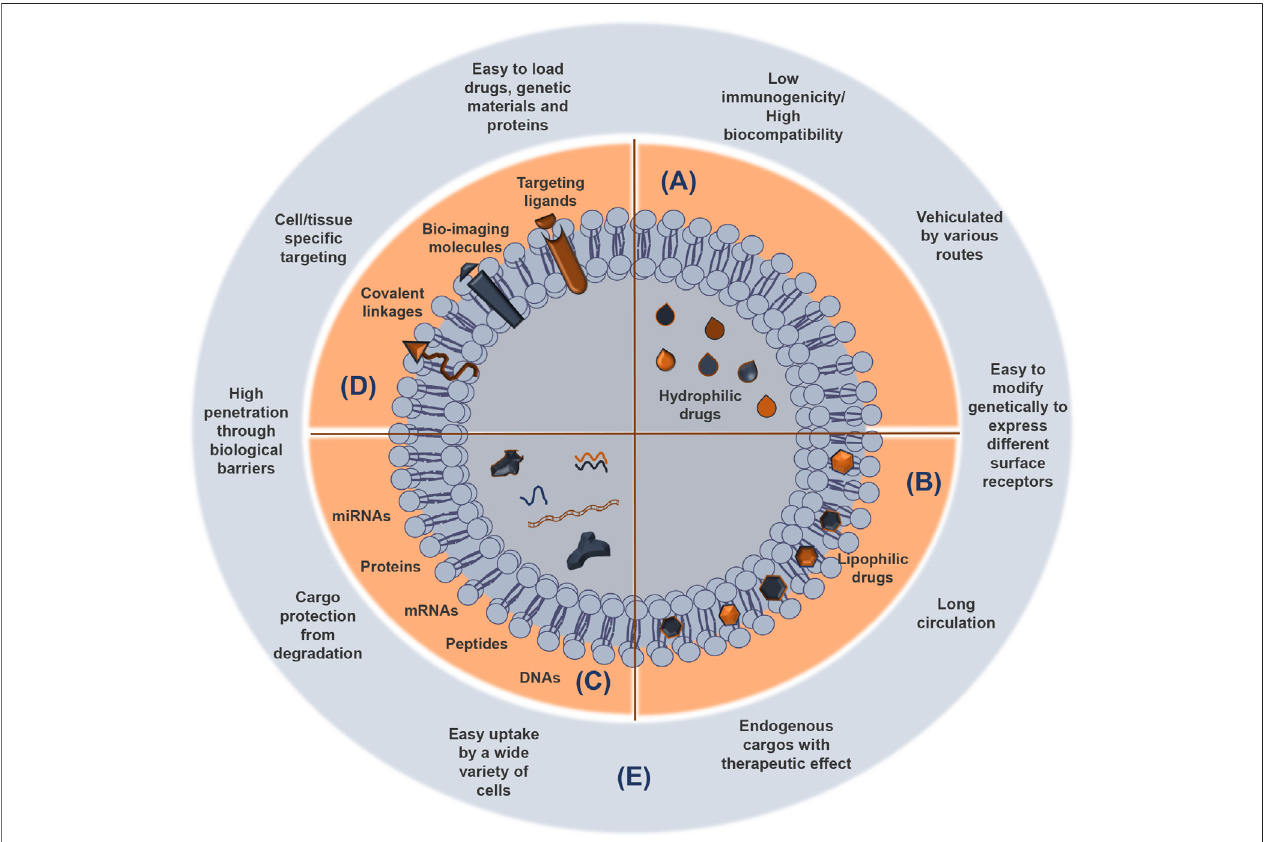
FIGURE 3 | sEV cargoes and advantages as delivery systems of functional and therapeutic molecules. Small extracellular vesicles (sEVs) consist of an aqueous compartmentsurroundedbyalipidbilayer.sEVscancompartmentalizeandsolubilizehydrophiliccompoundsintheaqueouscompartments (A) andlipophilicmolecules almost totally entrapped in the lipid layer (B) , which protects them from degradation. Agents with intermediary partition coef fi cient are equally distributed between the aqueousandthelipidcompartments.Protein,peptides,andgeneticmaterialcanbealsoreleasedfromsEVs (C) .Attachmentoftargetingcompounds,bio-imaging molecules,andcovalentlinkagetosEVsurfacecontributetoenhancetheirutilityasvehiclestodeliverbiomoleculesanddrugs (D) .Themostimportantadvantagesofthe sEVs as therapeutic nanocarriers are indicated (E) .